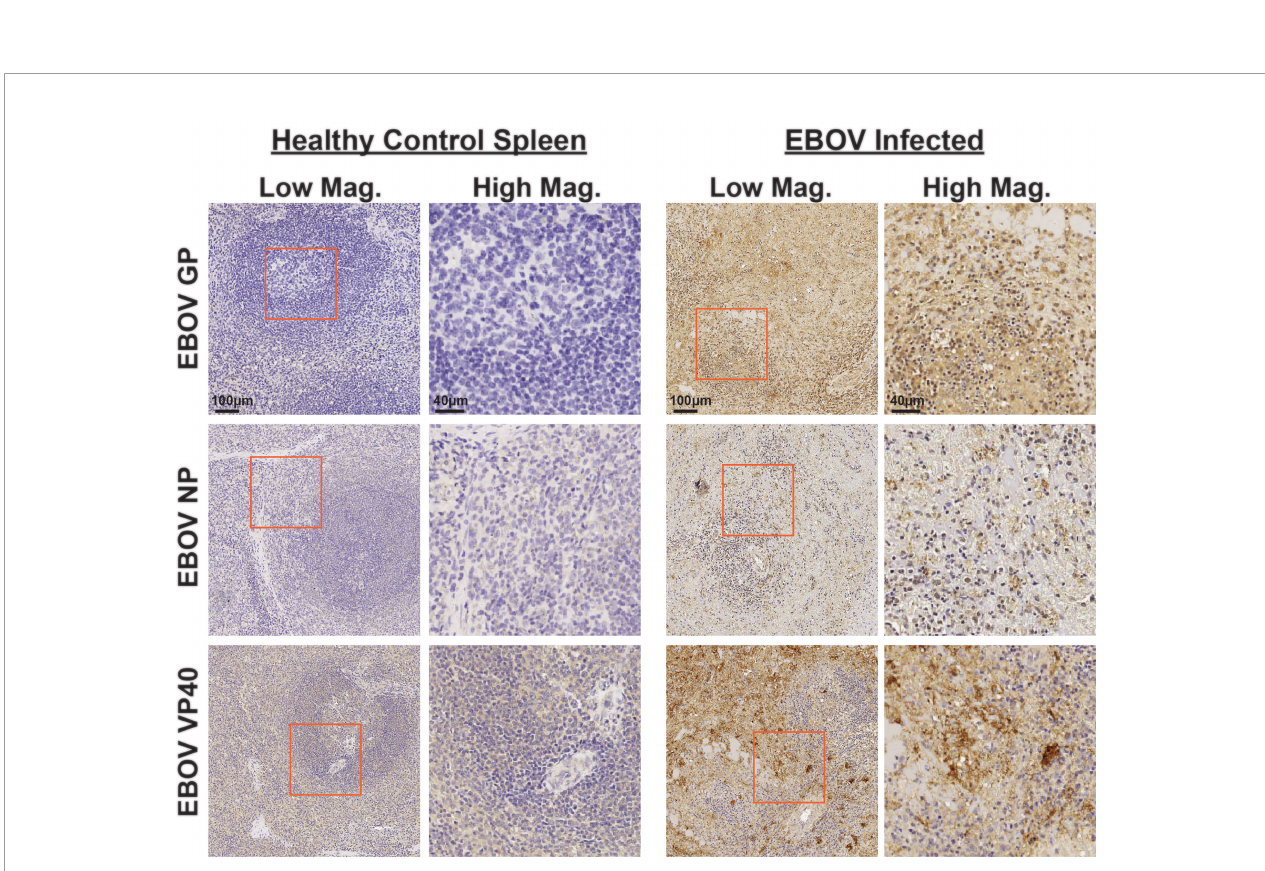
FIGURE 5 | Immunohistochemistry validation of anti-EBOV protein antibodies. Representative low magni fi cation (left, center right) and high magni fi cation (center left, right) IHC images for indicated EBOV protein markers on healthy control spleen sections (left) or spleen sections from EBOV challenged animals (right). Inlaid orange boxes on low magni fi cation images indicate the magni fi ed